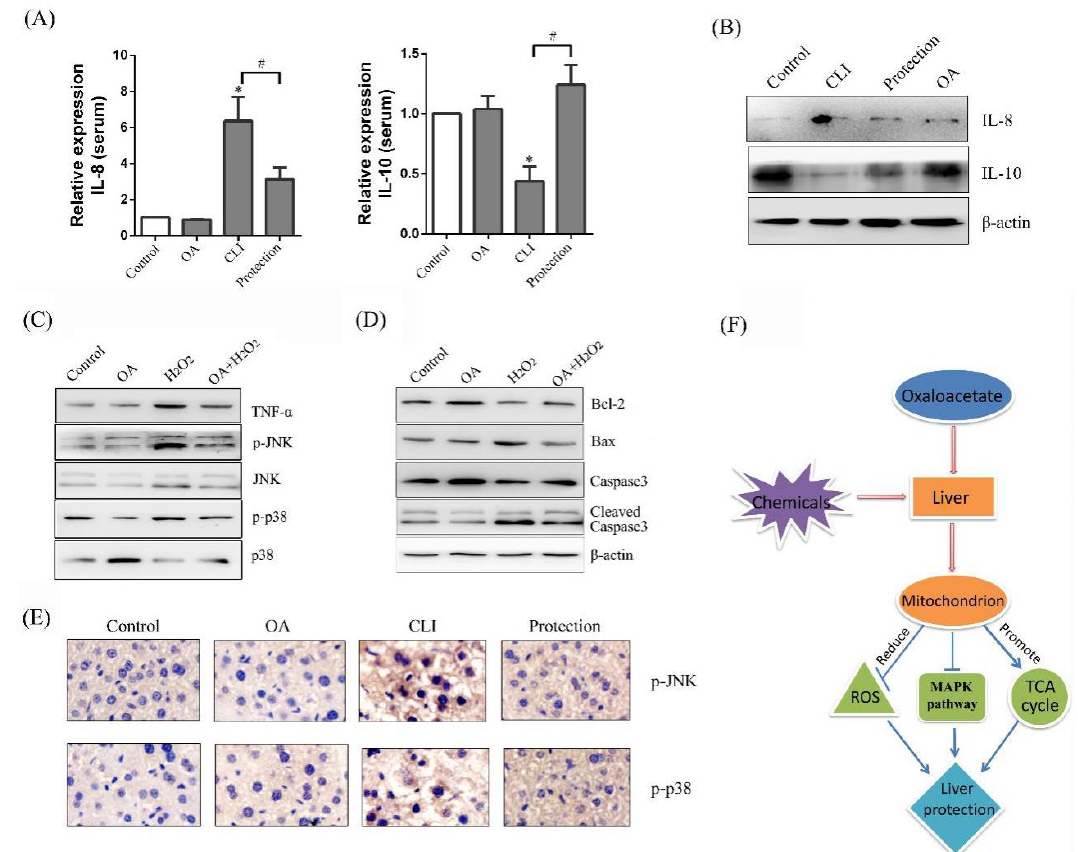
Figure 6. Effects of OA on mitogen-activated protein kinase (MAPK) pathway. ( A ) ELISA of IL-8 and IL-10 in the serum. Groups were as described in “Methods: animals”. The experiments were repeated at least three times. The results are presented as the mean ± SD. * p < 0.05, compared with the control. # p < 0.05, compared with the CLI group; ( B ) Western blot of interleukin-8 (IL-8) and IL-10 in the serum. Groups were as described in “Methods: animals”; ( C ) Western blot of tumor necrosis factor- α (TNF- α ), p-JNK, N-terminal kinase (JNK), p-p38, and p38 mitogen-activated protein kinase (p-38) in the LO-2 cells. Groups were as described in “Methods: Cell line and Reagents”; ( D ) Western blot of Bcl-2, Bax, Caspase3, Cleaved-caspase3, β -actin in the LO-2 cells; ( E ) Immunohistochemistry of p-JNK, p-p38 in the tissues (400×). Groups were as described in “Methods: animals”; ( F ) Schematic presentation of hepatoprotective effect of OA in the liver.